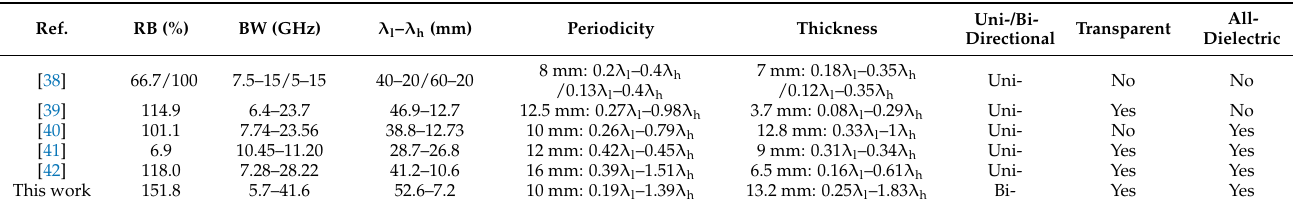
Table 2. Comparison with previous